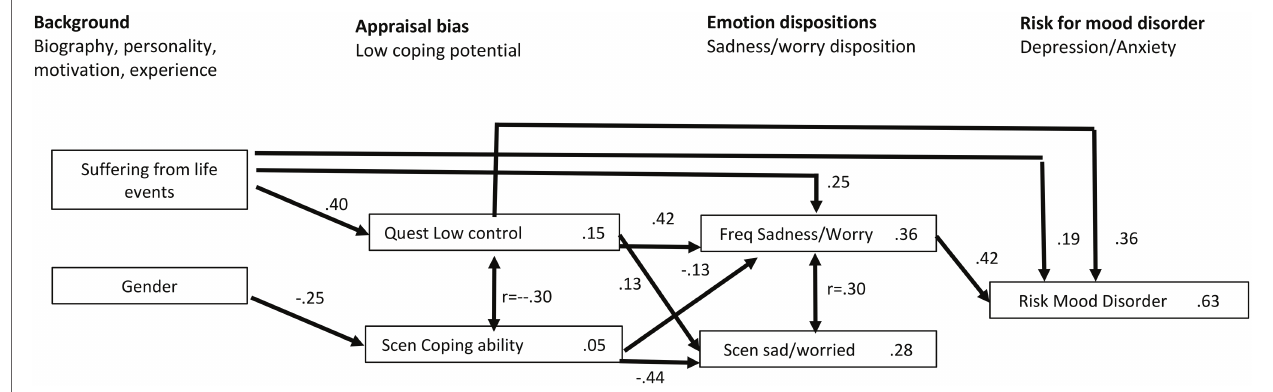
FIGURE 2 | Path diagram showing the combined results (significant predictors) of three subsequent hierarchical regression analyses: (1) dependent variable (depression/anxiety risk factor for mood disorder) on sadness/worry emotion disposition, appraisal bias, and background variables; (2) “Sadness/Worry” emotion disposition variables on appraisal bias and background variables; and (3) appraisal bias variables “Control” and “Coping Potential” on background variables. Path coefficients (beta) on arrows, Adj. adjusted R2 in boxes; risk for mood disorder = mean GAD/PHQ, Scen—Scenario measurements (appraisal, emotions, Freq— last 2 week frequency, Quest—control belief questionnaire; arrows shown only for beta coefficients with p > =